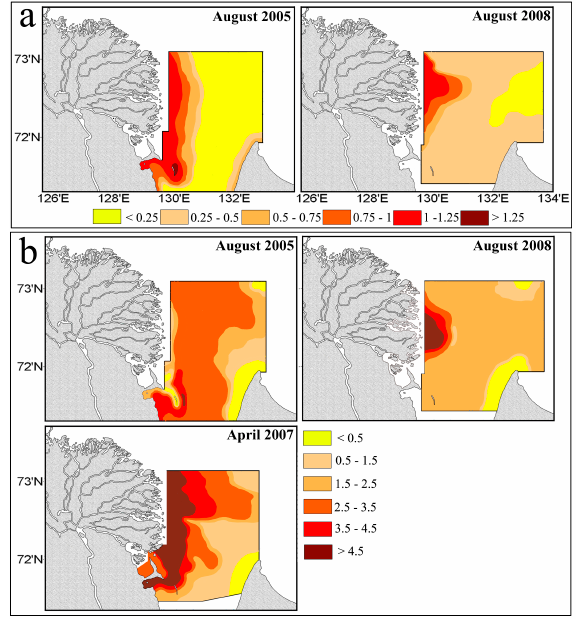
Fig. 6. OC content of (a) water column (POC, mgl − 1 ) and (b) bot- tom sediments (%).